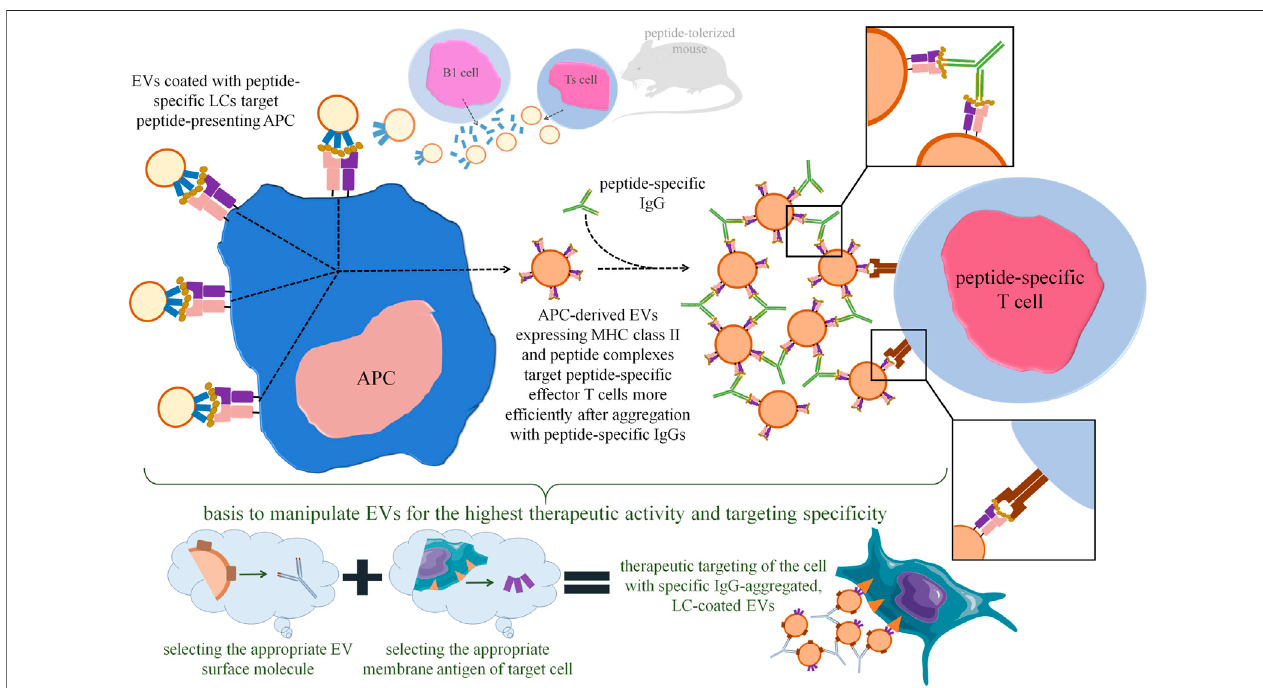
FIGURE 2 | Perspectives in increasing the therapeutic ef fi cacy of extracellular vesicles (EVs) with the use of antigen-speci fi c antibodies and light chains (LCs). Our research fi ndings demonstrated that tolerizing mice with antigen-coupled syngeneic erythrocytes activates suppressor T (Ts) cells to release EVs containing immune regulatory miRNA-150. These EVs are then coated with B1 lymphocyte-secreted, antigen-speci fi c LCs, which allows EVs to speci fi cally bind the antigenic peptide presented by antigen-presenting cell (APC). Importantly, Ts cell-derived EVs could also be in vitro coated with LCs of chosen speci fi city by simple co-incubation. The Ts-cell-EV-targeted APC releases its own EVs expressing major histocompatibility complex (MHC) class II and antigenic peptides that target peptide-speci fi c effector T cells by interacting with T-cell receptor (TCR). Incubation of APC-derived, MHC-expressing EVs with peptide-speci fi c IgG antibodies leads to vesicle aggregation,whichgreatlyenhancestheirimmunesuppressiveactivity byincreasingtheamountofEVstargetingeach effectorTcell. Basedontheseobservations,one can assume that therapeutic EVs in general could be manipulated to achieve the highest activity by aggregating them with IgG speci fi c for the selected EV surface molecule, and then by selectively directing them towards target cell with LCs speci fi c for the selected cell surface antigen.